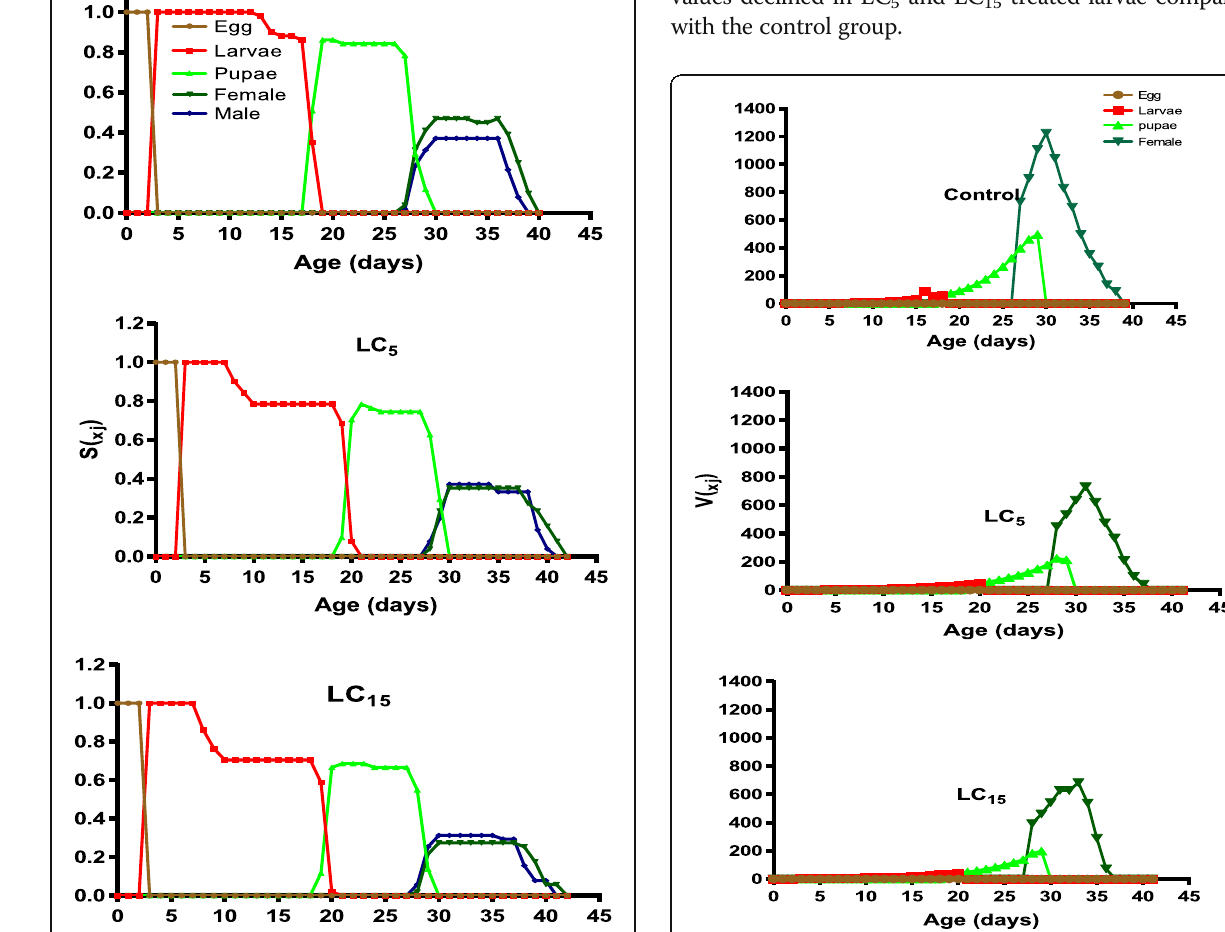
Fig. 2 Age-stage specific reproductive value ( V x,j ) of S. littoralis of individuals of age x and stage J exposed to sublethal concentrations of